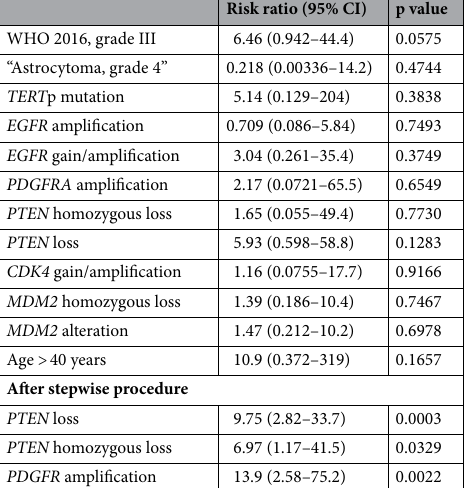
Table 3. Results of Cox proportional hazard model analysis of OS for each factor. The initial candidates (written above the bar) are all factors for which Kaplan–Meier analysis or log-rank testing showed significant results. CI confidence